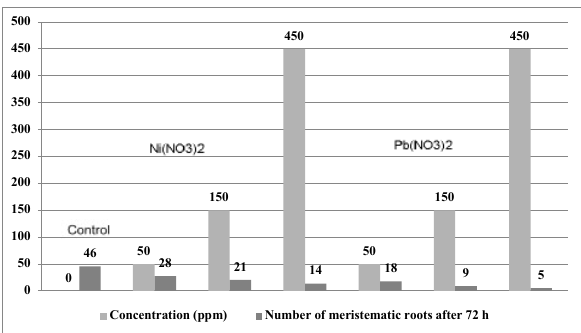
Fig. 1. The inhibitory effect of different concentrations of Ni(NO 3 ) 2 and Pb(NO 3 ) 2 on the rhizogenesis to A. sativum.